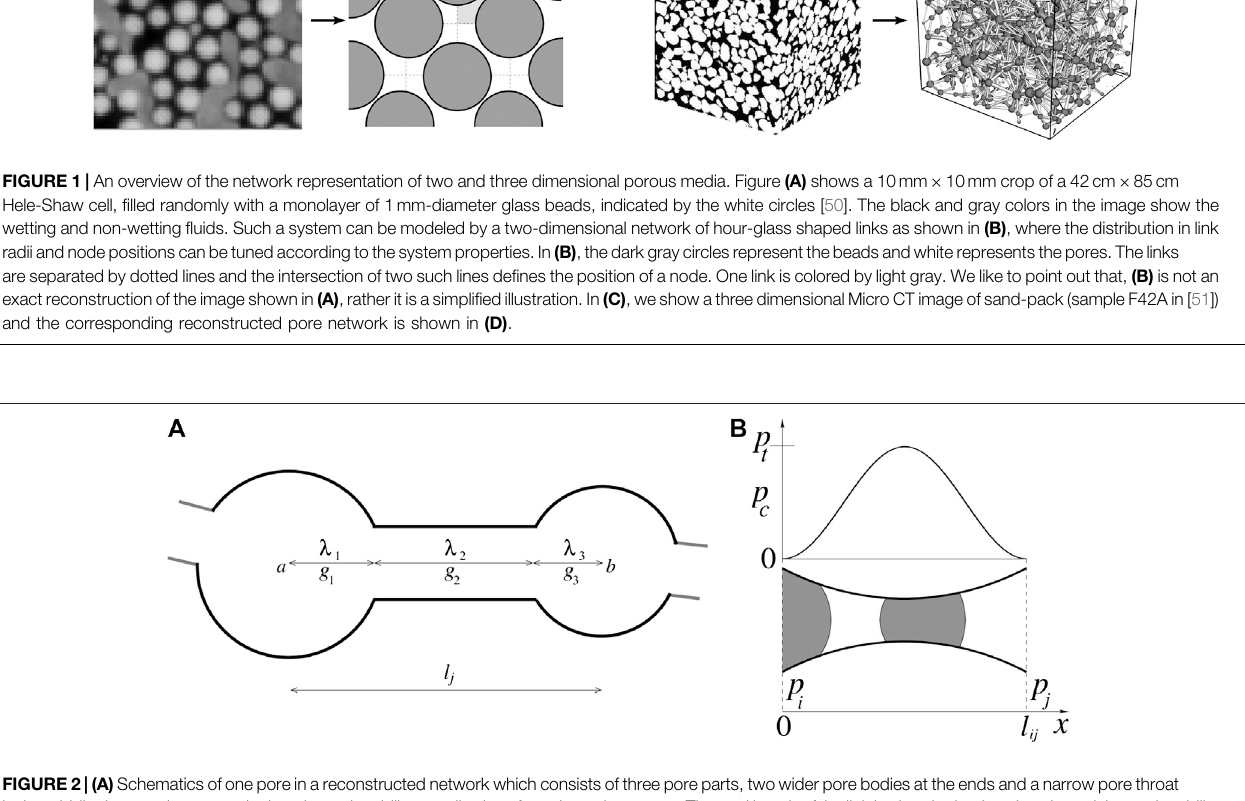
Frontiers in Physics |